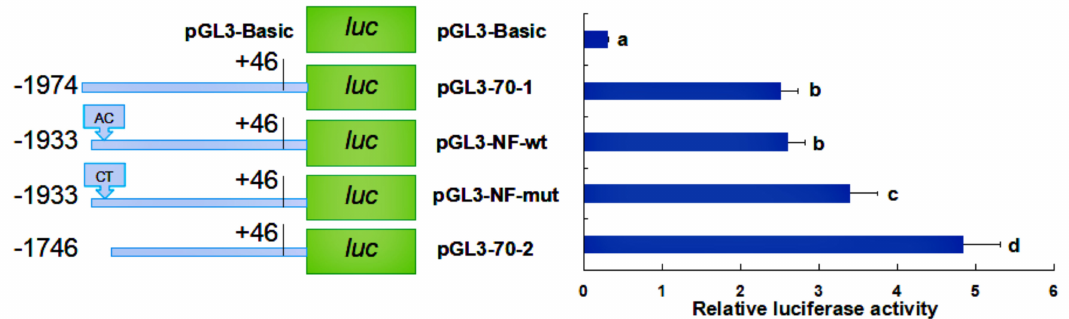
Figure 9. Activity analysis of the site-directed mutation plasmid pGL3-NF-mut. The distance between pGL3-70-1 and pGL3-70-2 contains a sole NF-1 binding site (TGACATTTCA) in the promoter of HdHSP70 . In addition, the binding sites of the transcription factor NF-1 is TGACATTTCA, so the recombinant plasmid was named pGL3-NF-wt. When AC was mutated into CT, the sequence became TGCTATTTCA, and the mutant recombinant plasmid was named pGL3-NF-mut. The pGL3-Basic plasmid was served as a negative control. Values are means ± SD of biological replicates ( n = 3). The different letters on the error bars represent significant differences, p < 0.05. Luc: luciferase expression plasmids.